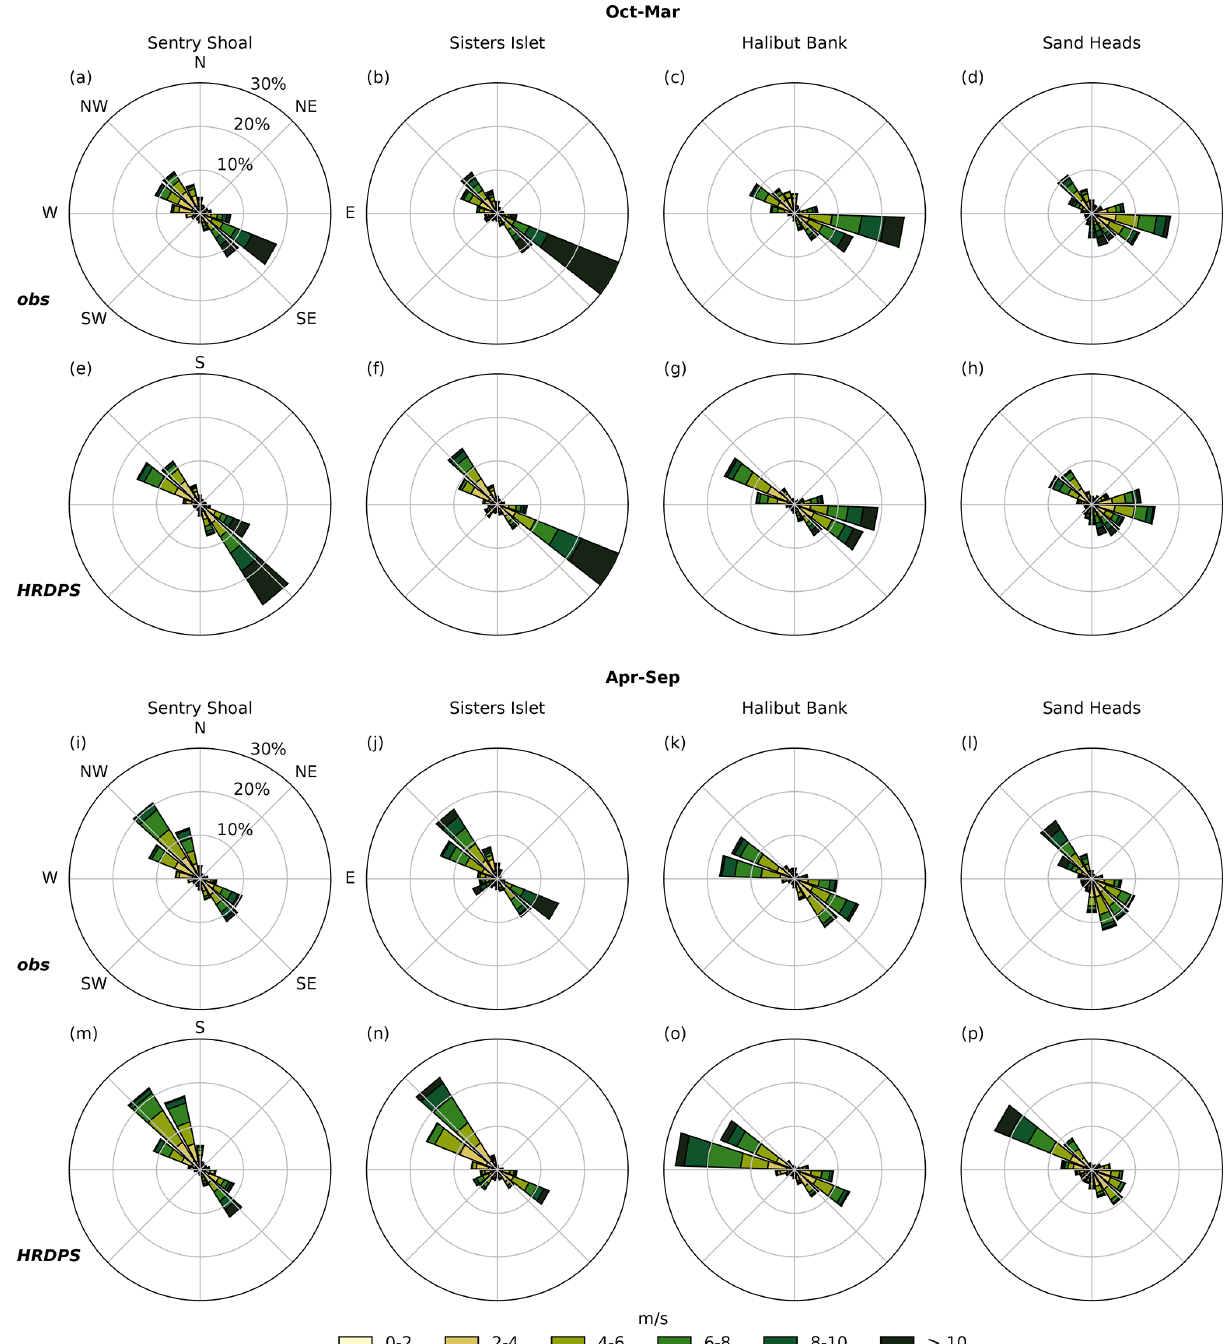
Figure 3. Condensed hourly wind station observations and hourly HRDPS results for the 2015 through 2019 period at Sentry Shoal (left column), Sisters Islet (second from left), Halibut Bank (second from right) and Sand Heads (right column). Data are binned by direction, and relative frequency of occurrence is given by the radial magnitude of each bin. Overall, the HRDPS wind record reproduces the observed along-axis wind dominance at all stations. The seasonal wind separation of strong winter southeasterlies and weaker summer northwesterlies is also